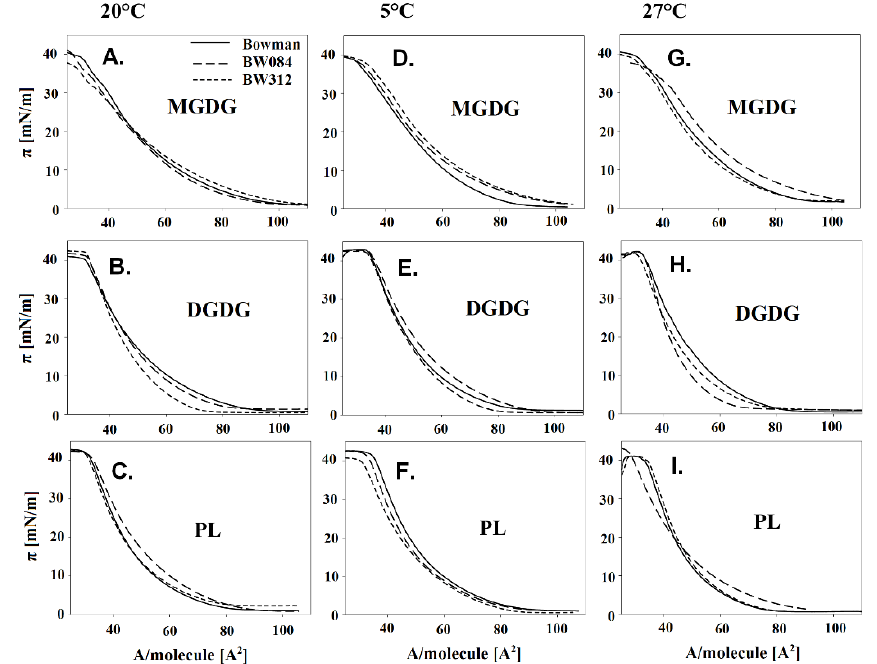
Figure 2. Exemplary Langmuir isotherms (surface pressure π vs area per molecule A ) for the monolayers of the galactolipids - MGDG (A, D, G), DGDG (B, E, H) and phospholipids - PL (C, F, I) that were obtained from the leaves of the barley WT Bowman, mutant BW084, and mutant BW312 cultured at 20 ◦ C ( A – C ) and then acclimated at 5 ◦ C ( D – F ) and 27 ◦ C ( G – I ). 3.2. Fatty Acid Composition of the Membrane Lipids from the Barley That Had Been Acclimated at 5 ◦ C and